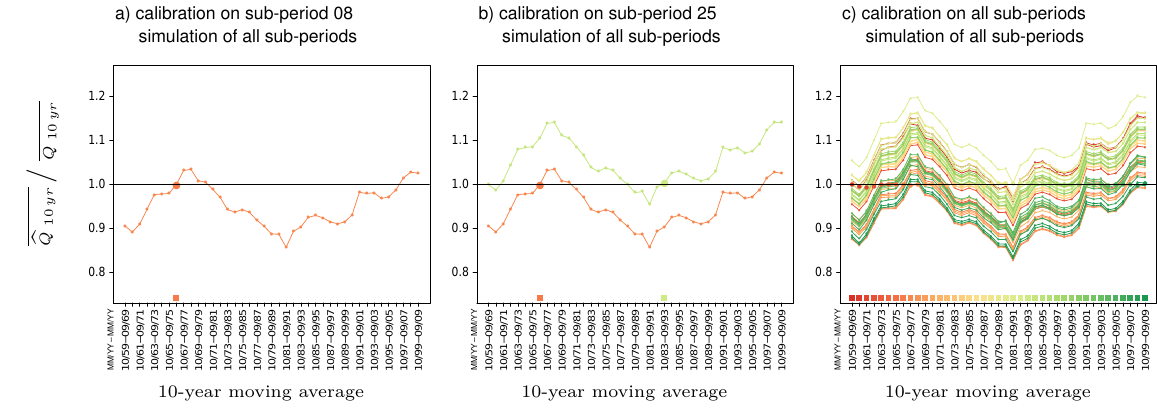
Fig. 4. Construction of the graphical representation of the series of 10yr mean flow volume